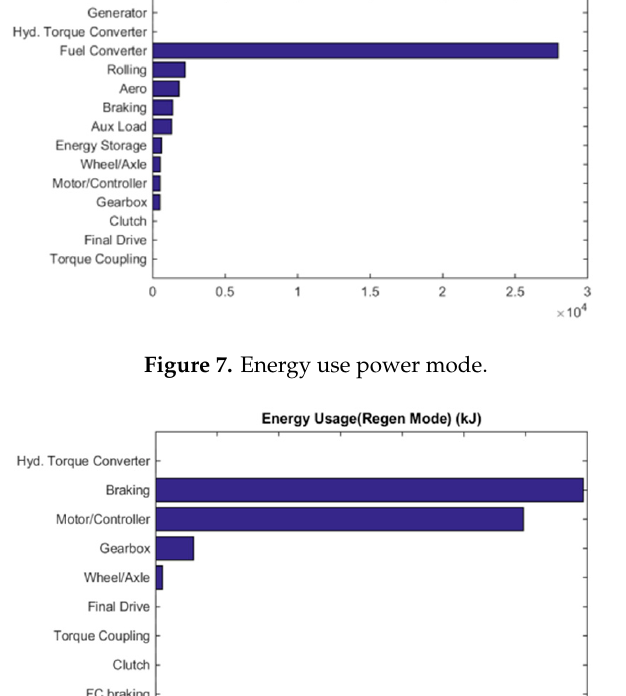
Figure 6. Motor torque-speed.